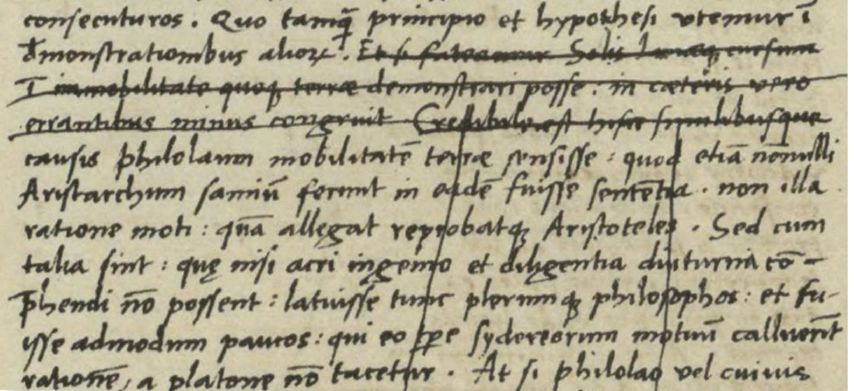
Figure 14. Part of page 22 of Book 1 of Copernicus’ manuscript showing the references to Philolaus, Aristarchus and the Greek cosmology, which he crossed out before publication of his book De revolutionibus (source: http://copernicus.torun.pl/en/archives/De_revolutionibus/1/ ?view=gallery&file=1&page=22, last access: 30 March 2021).